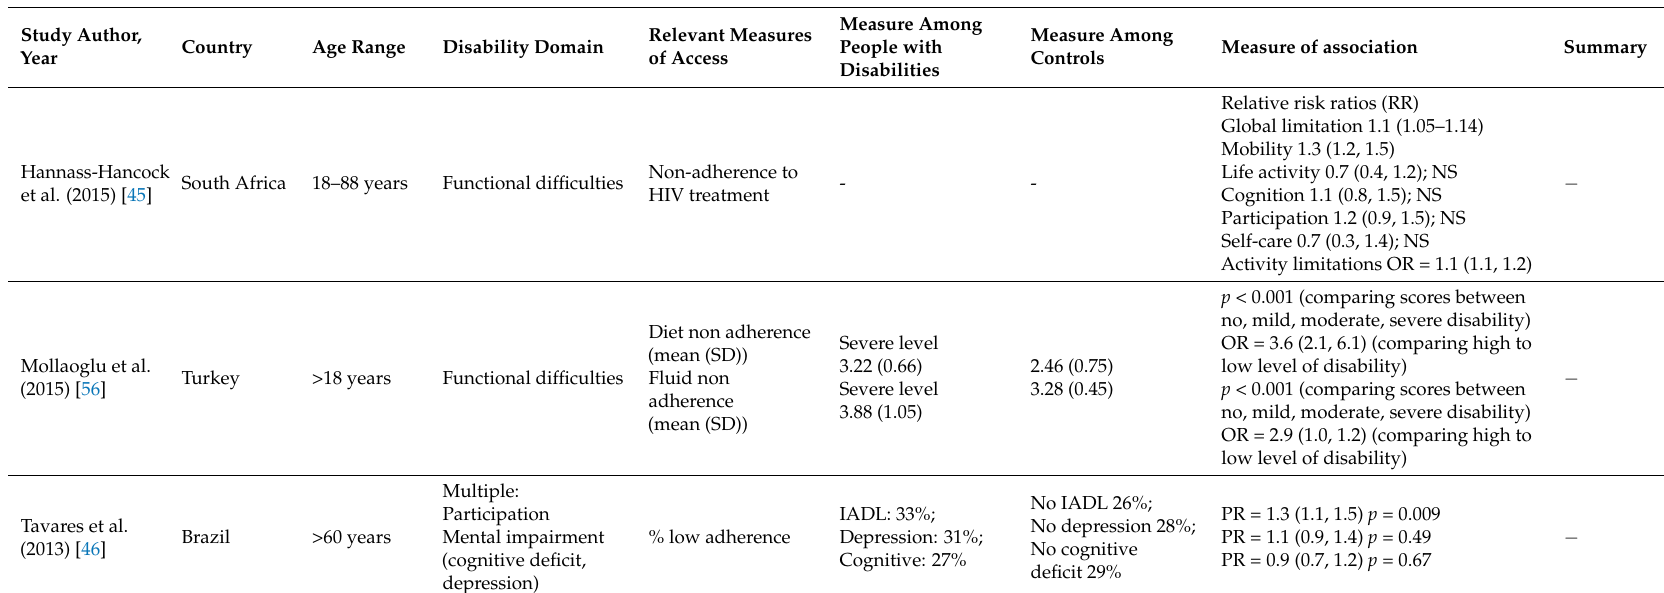
Table 6. Results of studies measuring